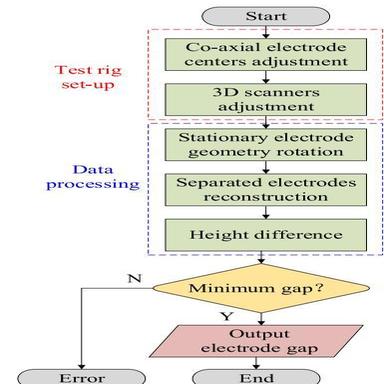
Flowchart of electrode gap measurement.